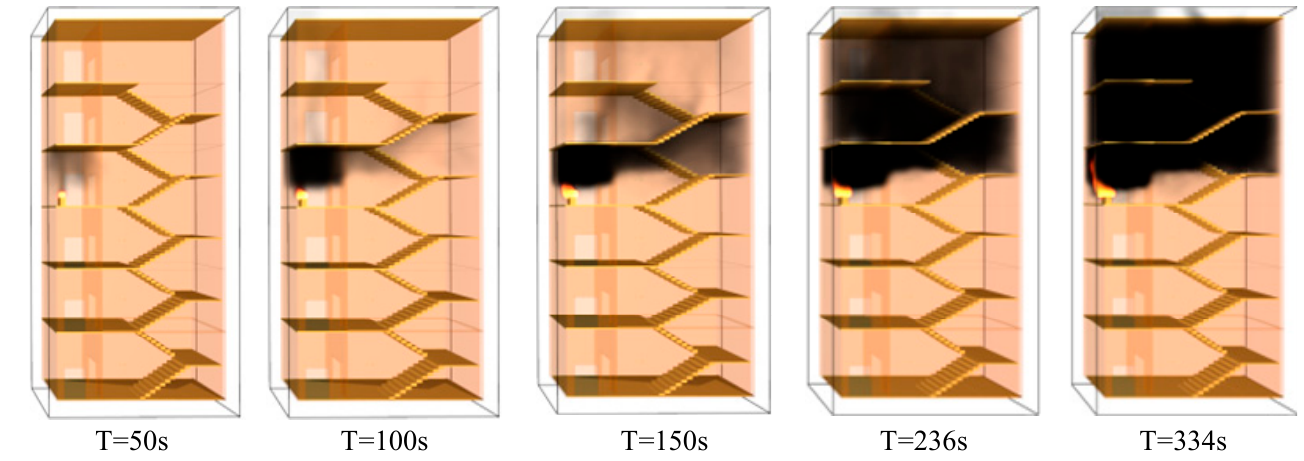
Figure 7. Smoke spread in the stairwell at different times.